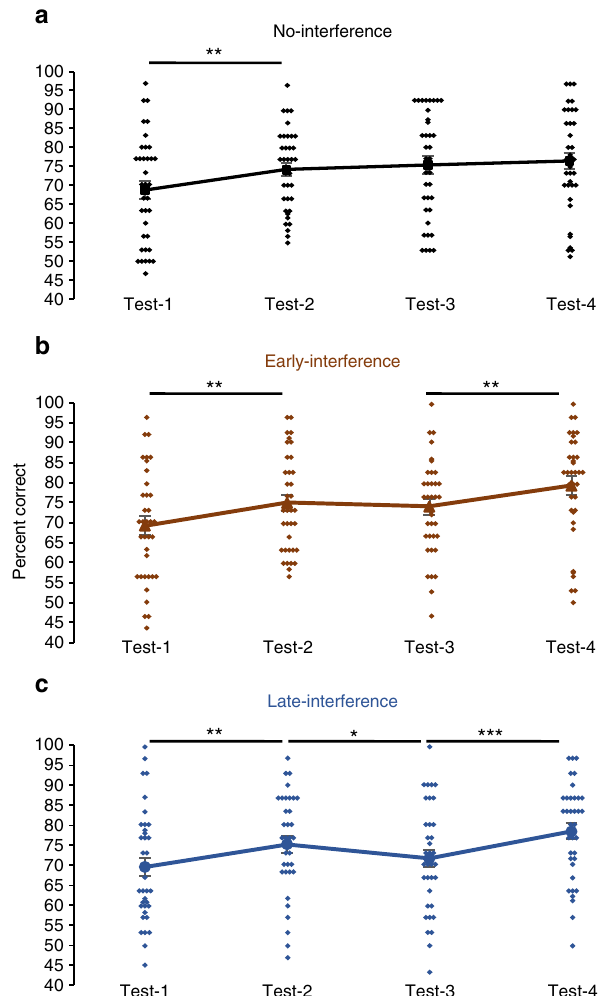
Fig. 2 Auditory classi fi cation performance in experiment-1. The mean percentage of trials responded to correctly in the four posttests is shown for the a no-interference, b early-interference, and c late-interference conditions. Testing took place at 12:00 p.m. on day-1 (test-1), at 12:00 p.m. on day-2 (test-2), at 5:30 p.m. on day-2 (test-3), and at 12:00 p.m. on day- 3 (test-4). The same 36 starlings completed each condition. Asterisks indicate signi fi cant differences between results at consecutive test times Error bars show standard error of the mean. Dot plots show